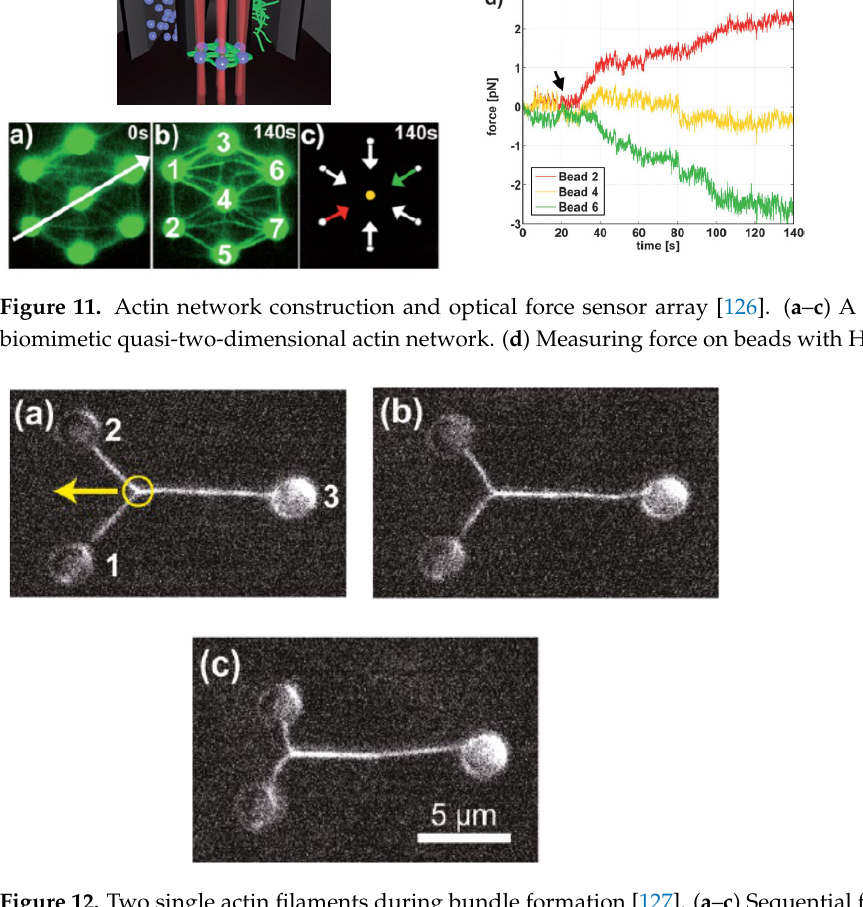
Figure 12. Two single actin filaments during bundle formation [127] . ( a – c ) Sequential fluorescence images of the bunding filaments. Yellow circle indicates the attachment between filaments, yellow arrow indicates the bunding axis. 3.3. Digital Hologram Digital holography microscopy (DHM) [62,128–130] is a label-free optical micro- scopic imaging system which is suitable for the study of biological samples study [64,131]. The computer program can numerically reconstruct the quantitative refractive index (RI) distribution inside bio-samples by digitally recording the interference pattern as a holo- gram. OT can rotate the orientation of the sample to a specified angle to gather part of the sample’s information. Bernecker et al. [132] measured the RI distribution for RBCs (red blood cells) from two perspective angles—when the long axis lies on the slide and when it is rotated by the OT to perpendicular to the slide. This application is extended to real 3D imaging in holographic tomography [66,133–136], which employs beam-rotation [137,138] or sample-rotation schemes [63,67,136,139,140] to scan entire samples under the different angles of illumination and calculate the integral phase. The beam-rotation method can be implemented by using a galvano-mirror, LCD, or digital micro-mirror de- vice (DMD), which keeps the sample and the observation system static. The beam-rotation